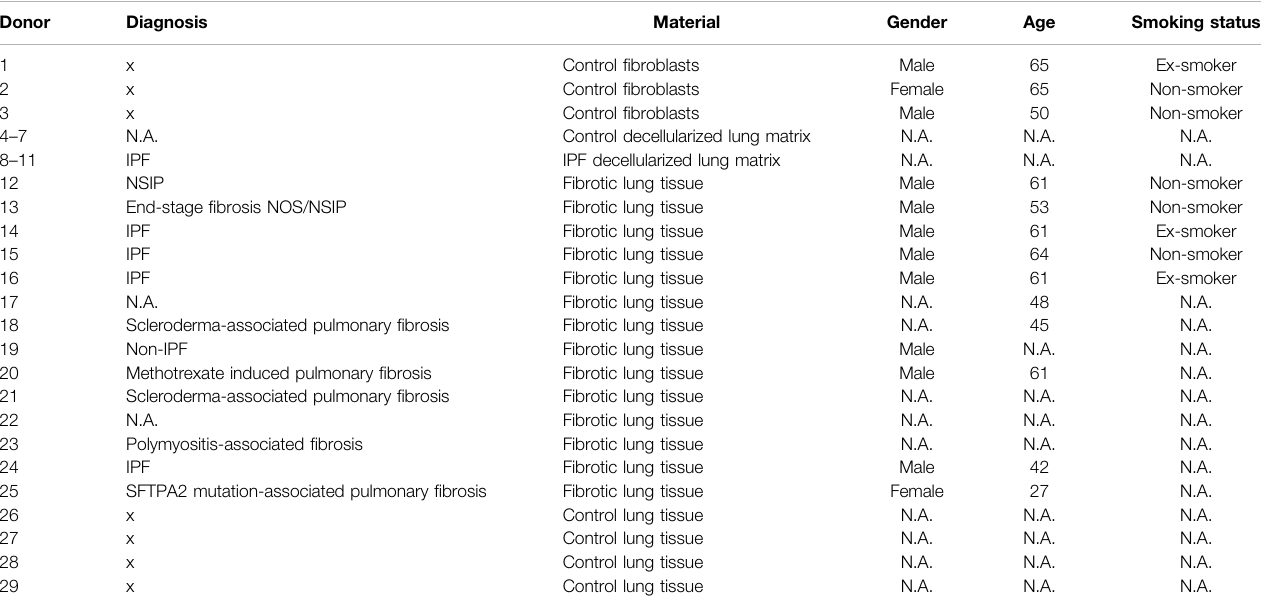
TABLE 1 | Overview of lung tissue and lung fi broblast donor